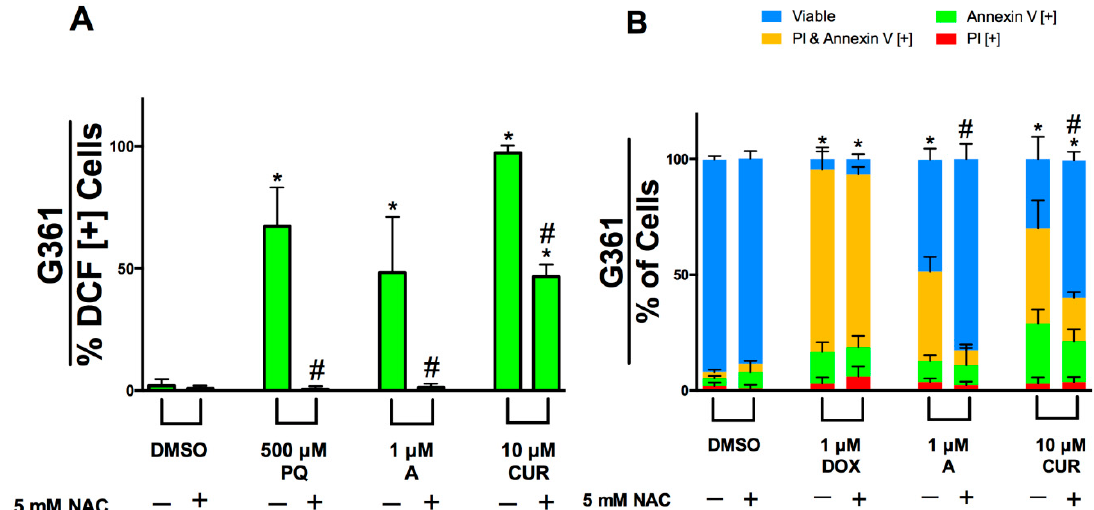
Figure 6. Induction of apoptosis by Compound A is dependent on the production of reactive oxygen species. ( A ) G361 cells were pre-treated with H 2 DCFDA and treated with Compound A and curcumin with or without the antioxidant N-Acetyl-L-cysteine (NAC) for 3 h, as described in the materials and methods section. Production of ROS was evaluated through image-based cytometry with the y -axis indicative of the percent of DCF positive cells. * p < 0.05 vs. DCF [ + ] cells of DMSO control; # p < 0.05 vs. DCF [ + ] cells of groups treated without NAC. ( B ) G361 cells were treated with the Compound A and curcumin with or without NAC for 48 h. Subsequently, cells were stained with Annexin V and PI, as described in the materials and methods. Image based cytometry was utilized to assess apoptosis. The y -axis represents the percent of cells positive for Annexin V (green), PI (red), Annexin V and PI (yellow), or negative for both Annexin V and PI (blue). All graphical values are expressed as a mean ± SD from three independent experiments. Doxorubicin (DOX) was used as a positive control. * p < 0.05 vs. DMSO control (comparison of viable cells only); # p < 0.05 vs. groups treated without NAC (comparison of viable cells only). PQ = Paraquat, A = Compound A, CUR = Curcumin.